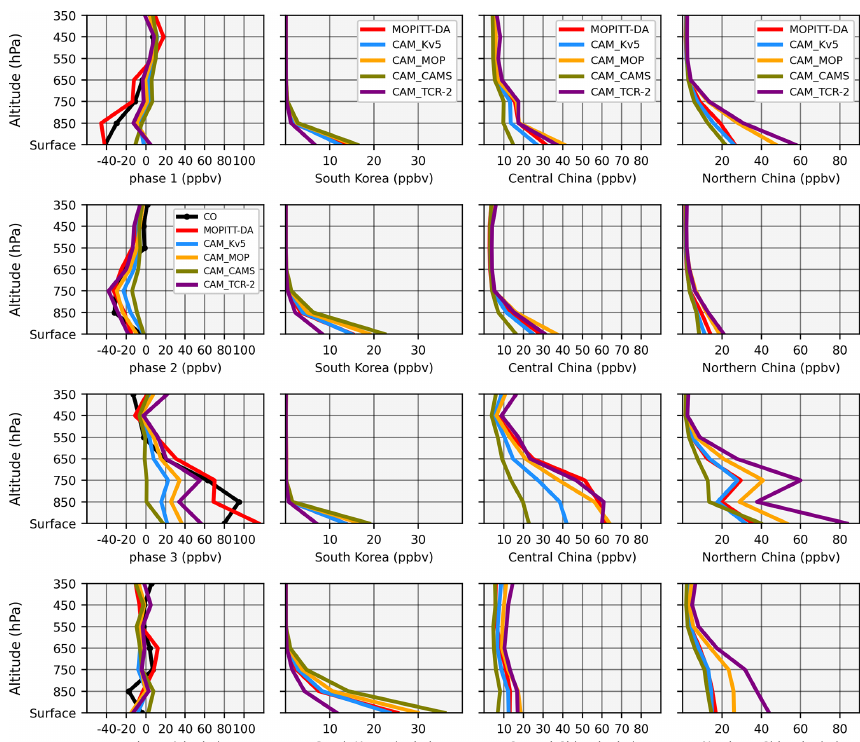
Figure 8. Average CO anomalies for the four different phases of KORUS-AQ (first column). The anomaly is defined by subtracting the respective average vertical profile (see Fig. 2). Absolute vertical profiles of the CO tags are shown from South Korea (second column), central China (third column), and northern China (fourth column). Each row corresponds to a different